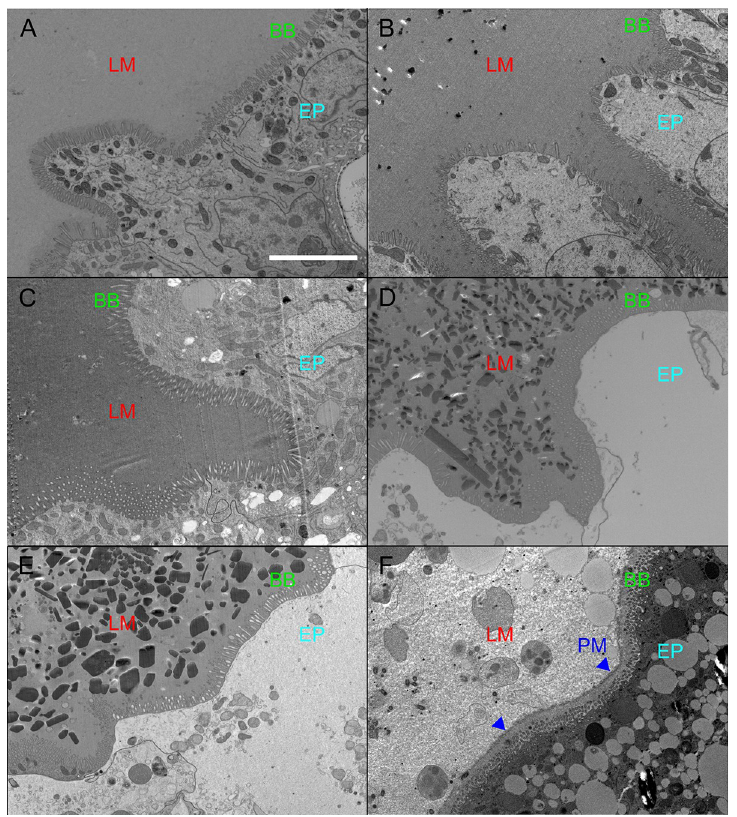
Fig 5. Absence of a detectable peritrophic matrix in the X . cheopis midgut following blood feeding. Electron micrographs of the X . cheopis midgut epithelium either A) 0, B) 4, C) 8, D) 12, or E) 24h after blood feeding; or F) the gut of an I . scapularis nymph 72 h following host attachment. An obvious peritrophic matrix is seen in I . scapularis but not X . cheopis . Lumen (LM), Brush border (BB), Epithelium (EP), Peritrophic matrix (PM). Images are representative of the digestive tracts of 3 female fleas (4 fields/flea) dissected and fixed following a sterile blood meal. Scale bar = 5 μ m. are relatively large and easy to excise from the rest of the digestive tract, the tracheal system consists of a series of branching tubes, which gradually give rise to finer tubes, the tracheoles,